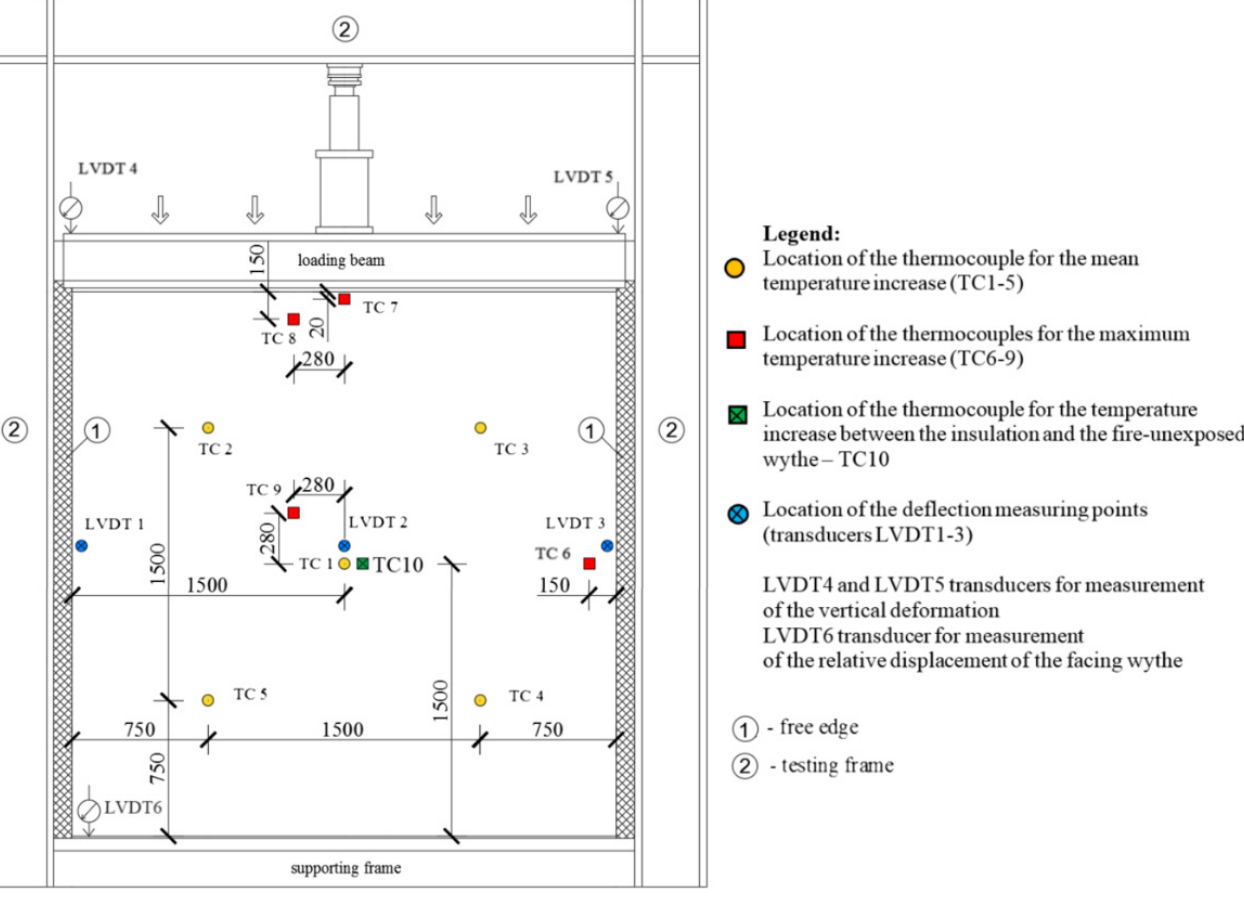
Figure 5. Locations of the temperature and deformation measuring points, as well positioning of the test specimen in the testing frame of the furnace, in mm. The deformations of the walls were measured with linear-variable inductive trans- ducers (LVDTs). The horizontal deformations were measured at the three points at the mid-height of the wall (LVDT 2) in the middle and on both left (LVDT 1) and right (LVDT 3) sides, close to the edges. The locations of the measuring points are shown in Figure 5. The vertical deformations were measured on both left (LVDT 4) and right (LVDT 5) sides of the head of the wall (see Figure 5). Additionally, in Test 1 and Test 3, the relative dis- placement of the facing wythe in relation to the load-bearing wythe was determined by measuring the vertical displacement of the facing wythe on the bottom edge (LVDT 6). In Test 2, this measurement was not possible because the facing wythe was enclosed within the furnace. The 400-kilonewton load cell was used to control applied vertical load. All data records were taken at the frequency of 0.2